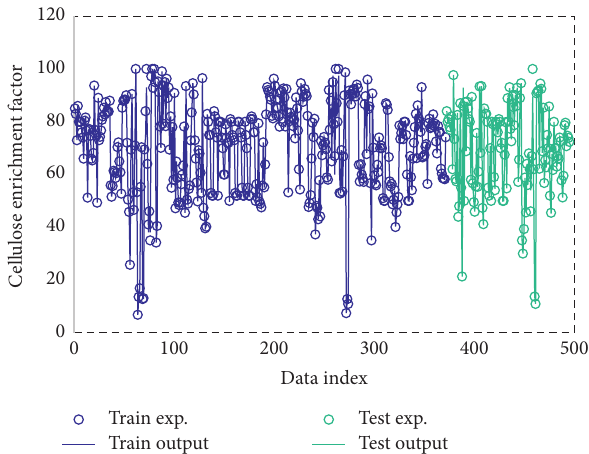
Figure 3: Simultaneous viewing of real and modeled CEF output